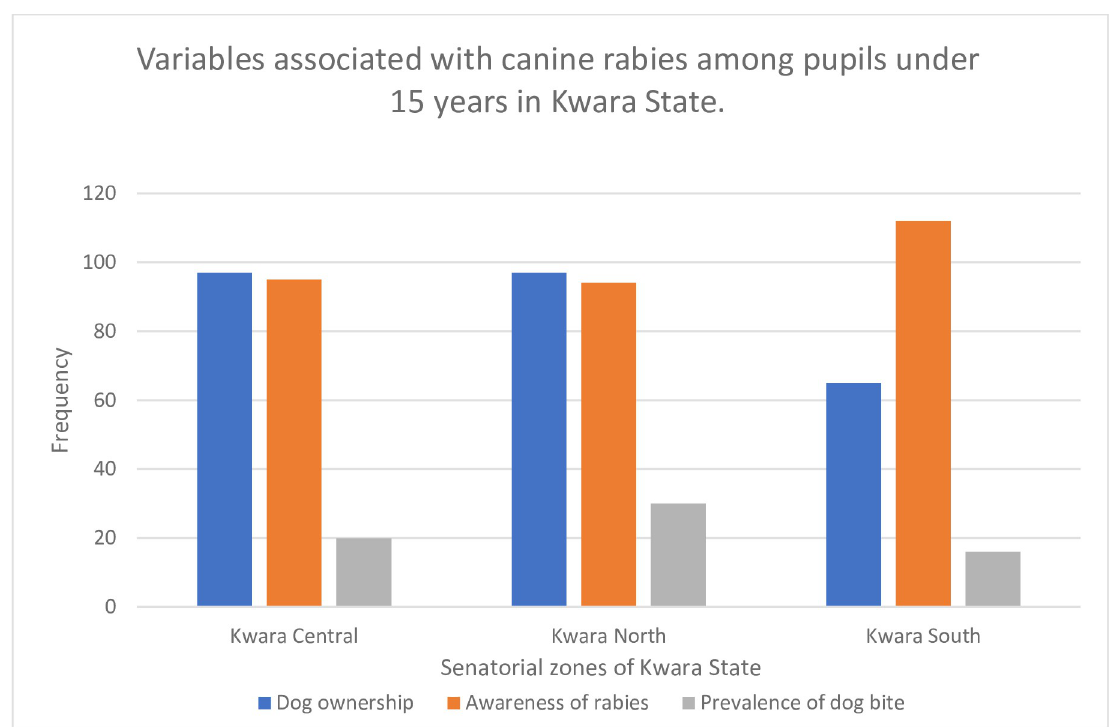
Fig 2. Assessment of dog ownership, awareness of rabies, and prevalence of dog bites among pupils under 15 years in Kwara State.